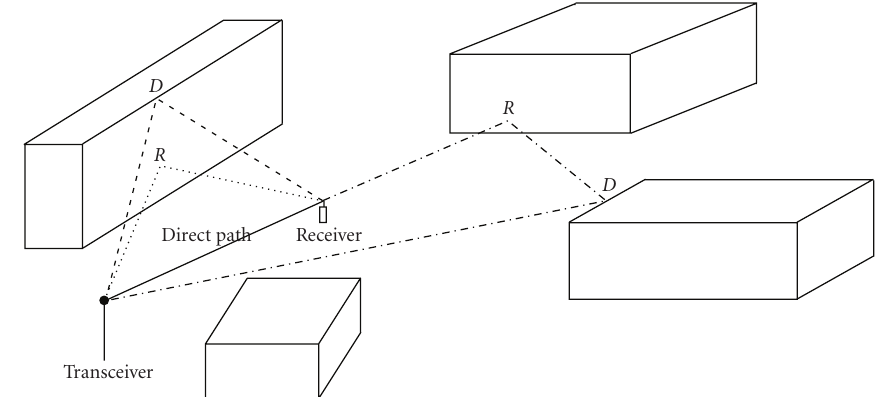
Figure 2: Multipaths phenomenon: R is a reflexion point, and D is a di ff raction one.